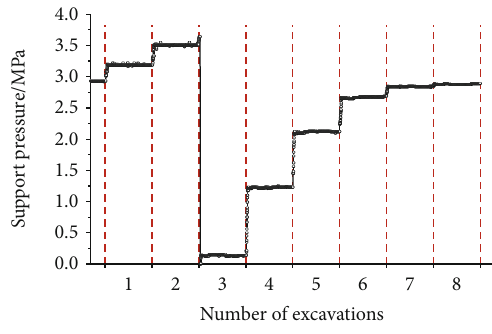
Figure 12: Pressure changes monitored by No.2 stress